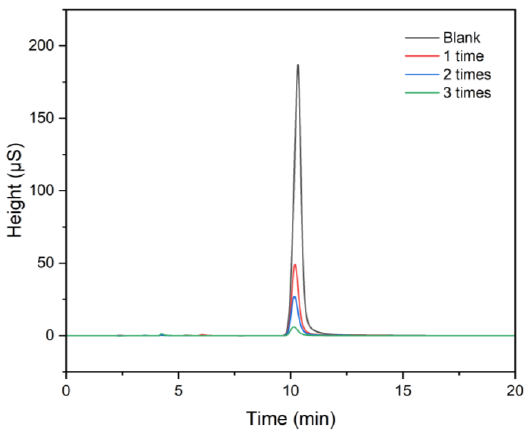
Figure 10. Ion chromatography results of the specimens before and after treatment. Table 1. The SO 4 2− ion content of the specimens with different treatment numbers.